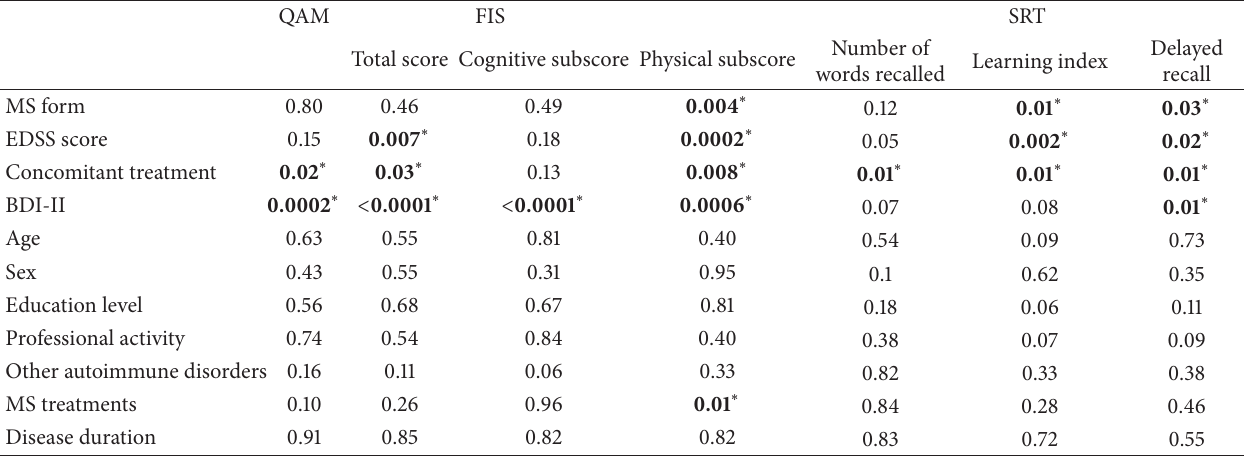
Table 4: Correlations between the clinical and therapeutic characteristics and the SRT, QAM, and FIS scores. QAM FIS SRT Number of Total score Cognitive subscore Physical subscore words